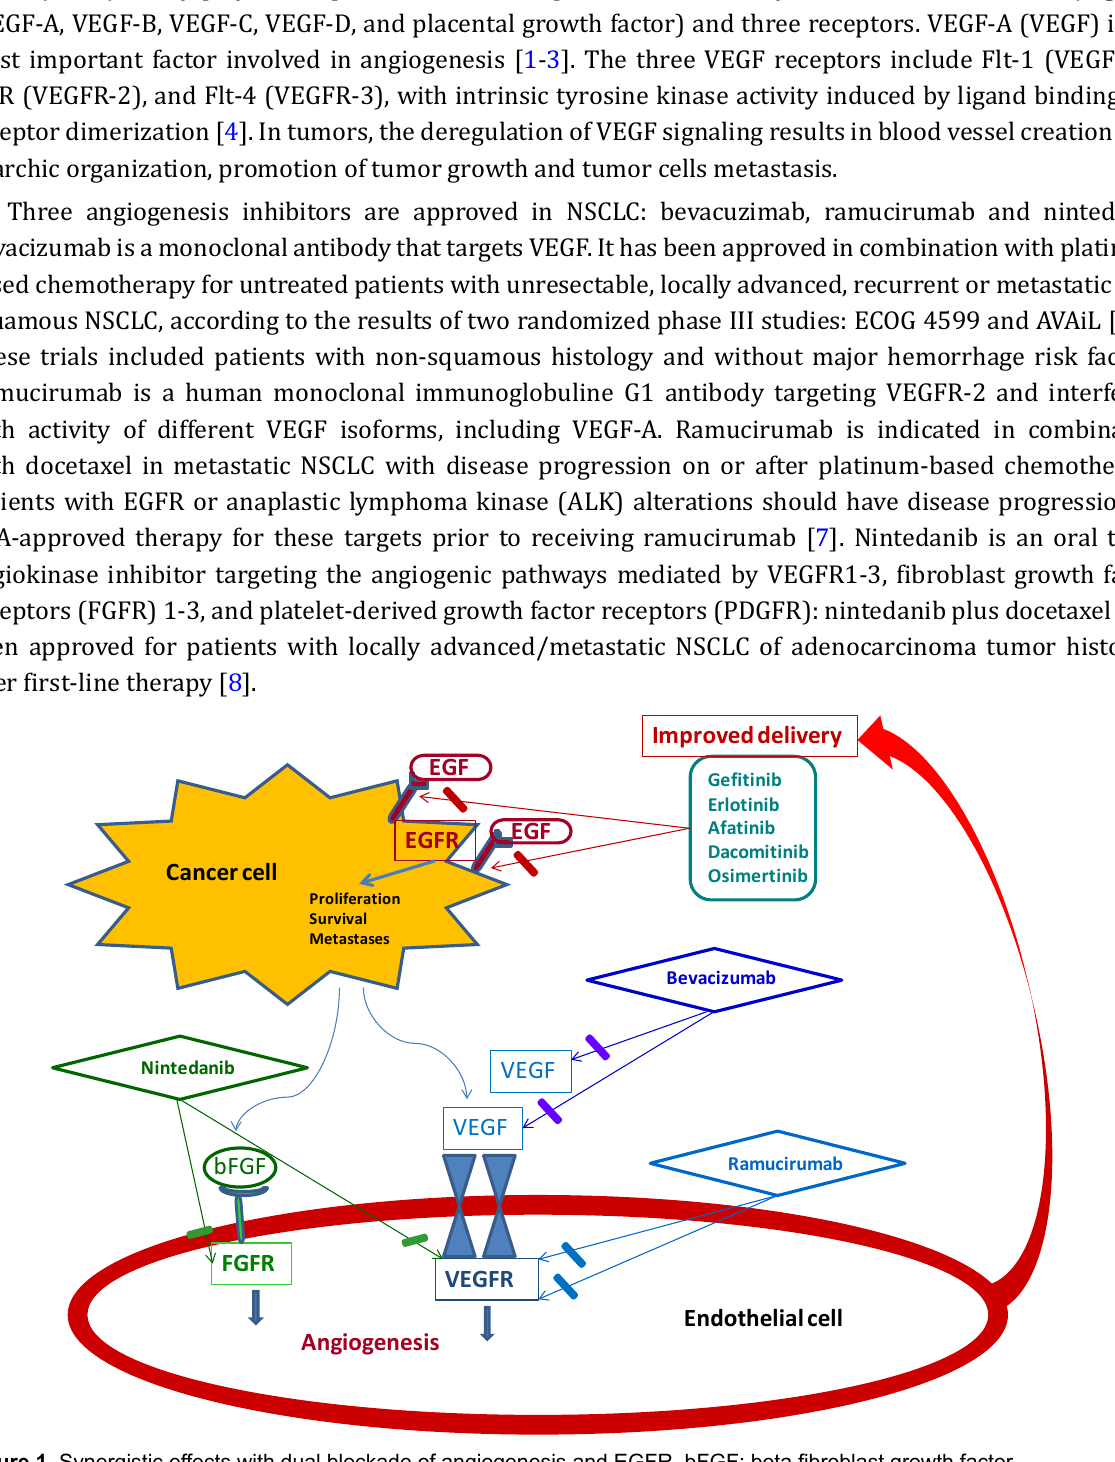
Figure 1. Synergistic effects with dual blockade of angiogenesis and EGFR. bFGF: beta fibroblast growth